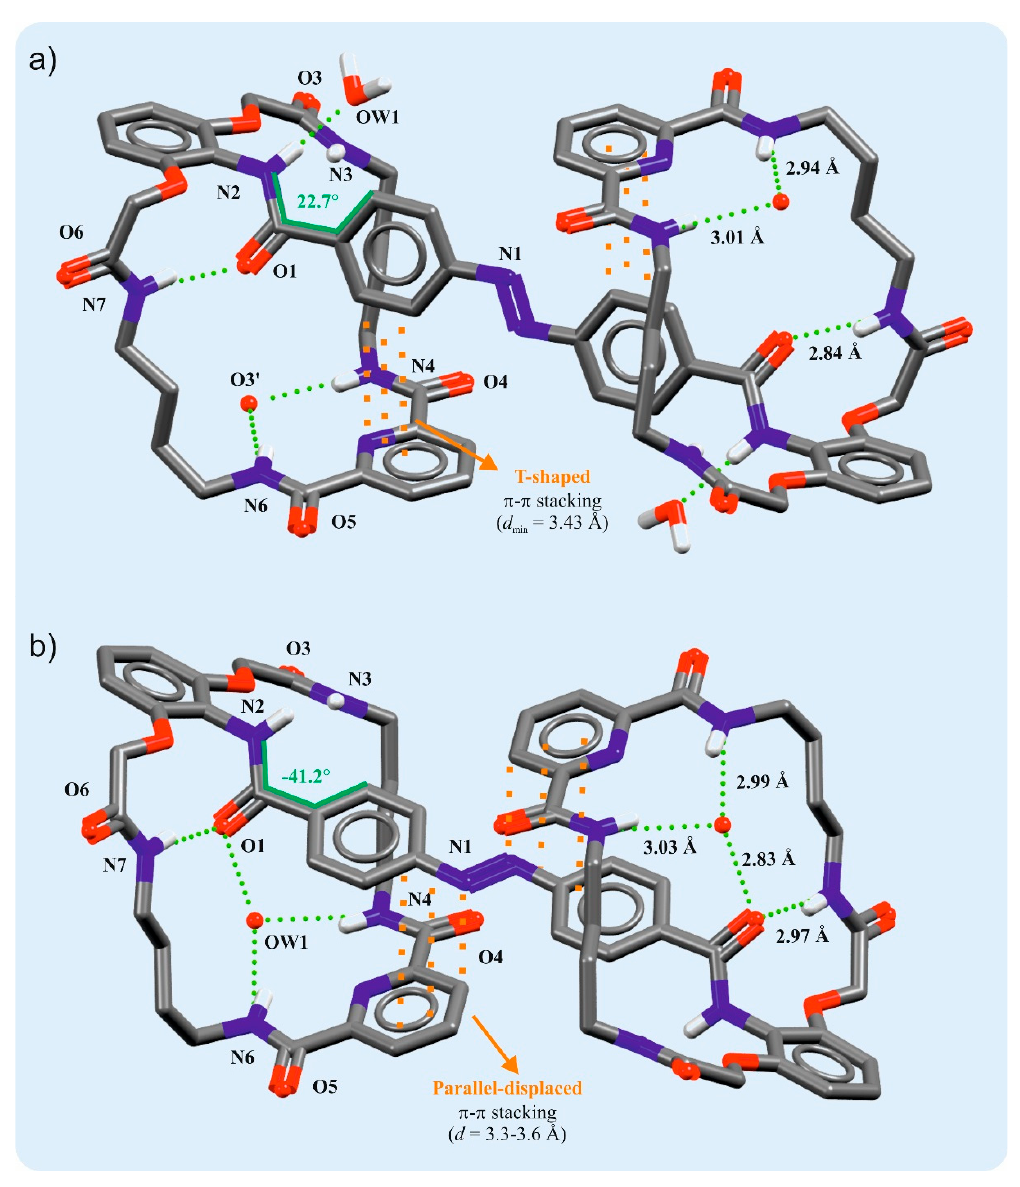
Figure 2. The X-ray crystal structures of solvate s of trans - 1, exemplifying T -shape ( a , solvate a) or parallel-displaced ( b , solvate b) π - π stacking interactions between azobenzene and pyridine-2,6- dicarboxamide moieties; non-acidic protons, non-relevant solvent molecules and disorder have been omitted for clarity.